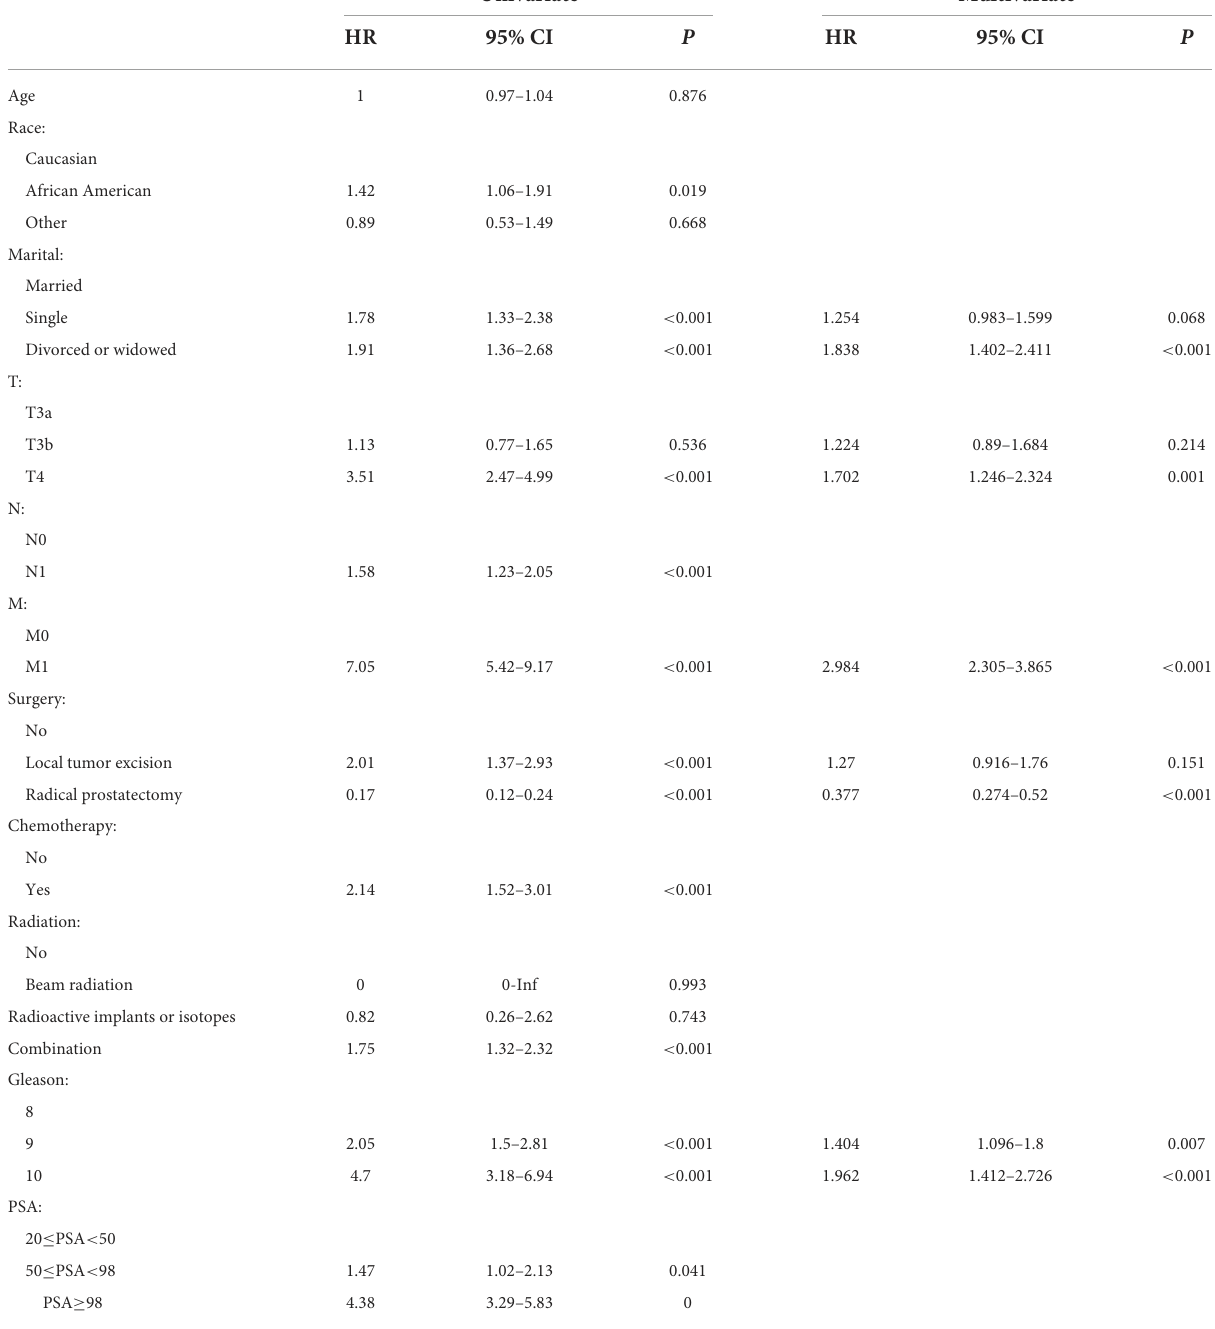
TABLE 3 Univariate and multivariate analyses of OS in training cohort. Univariate